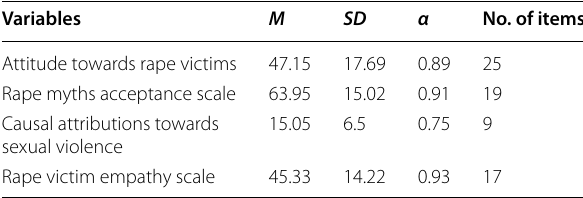
Table 2 Psychometric properties of